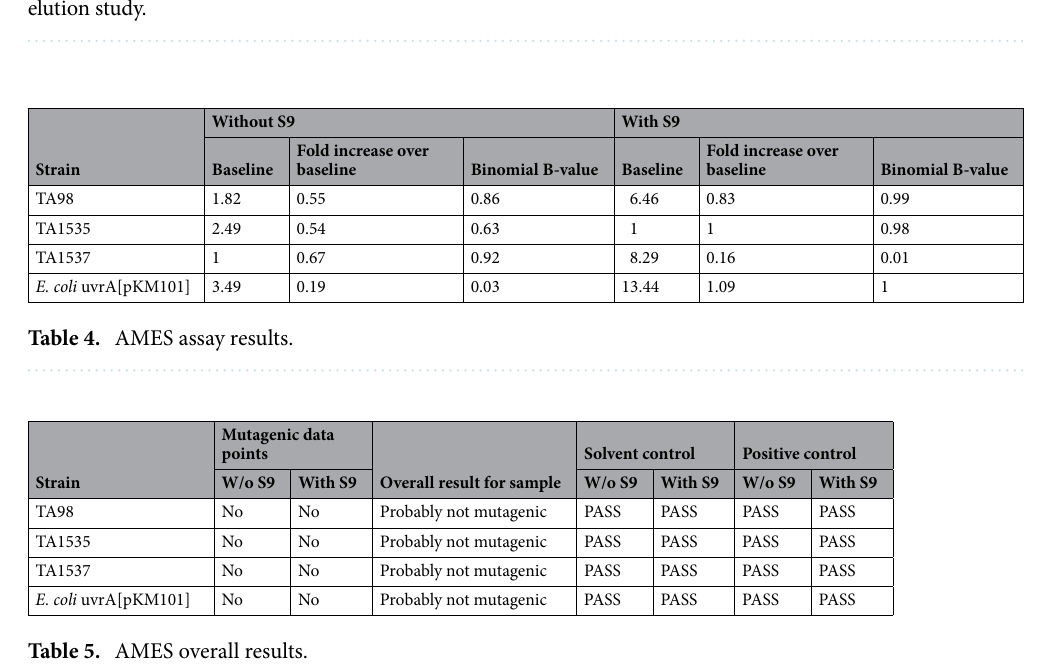
Table 5. AMES overall